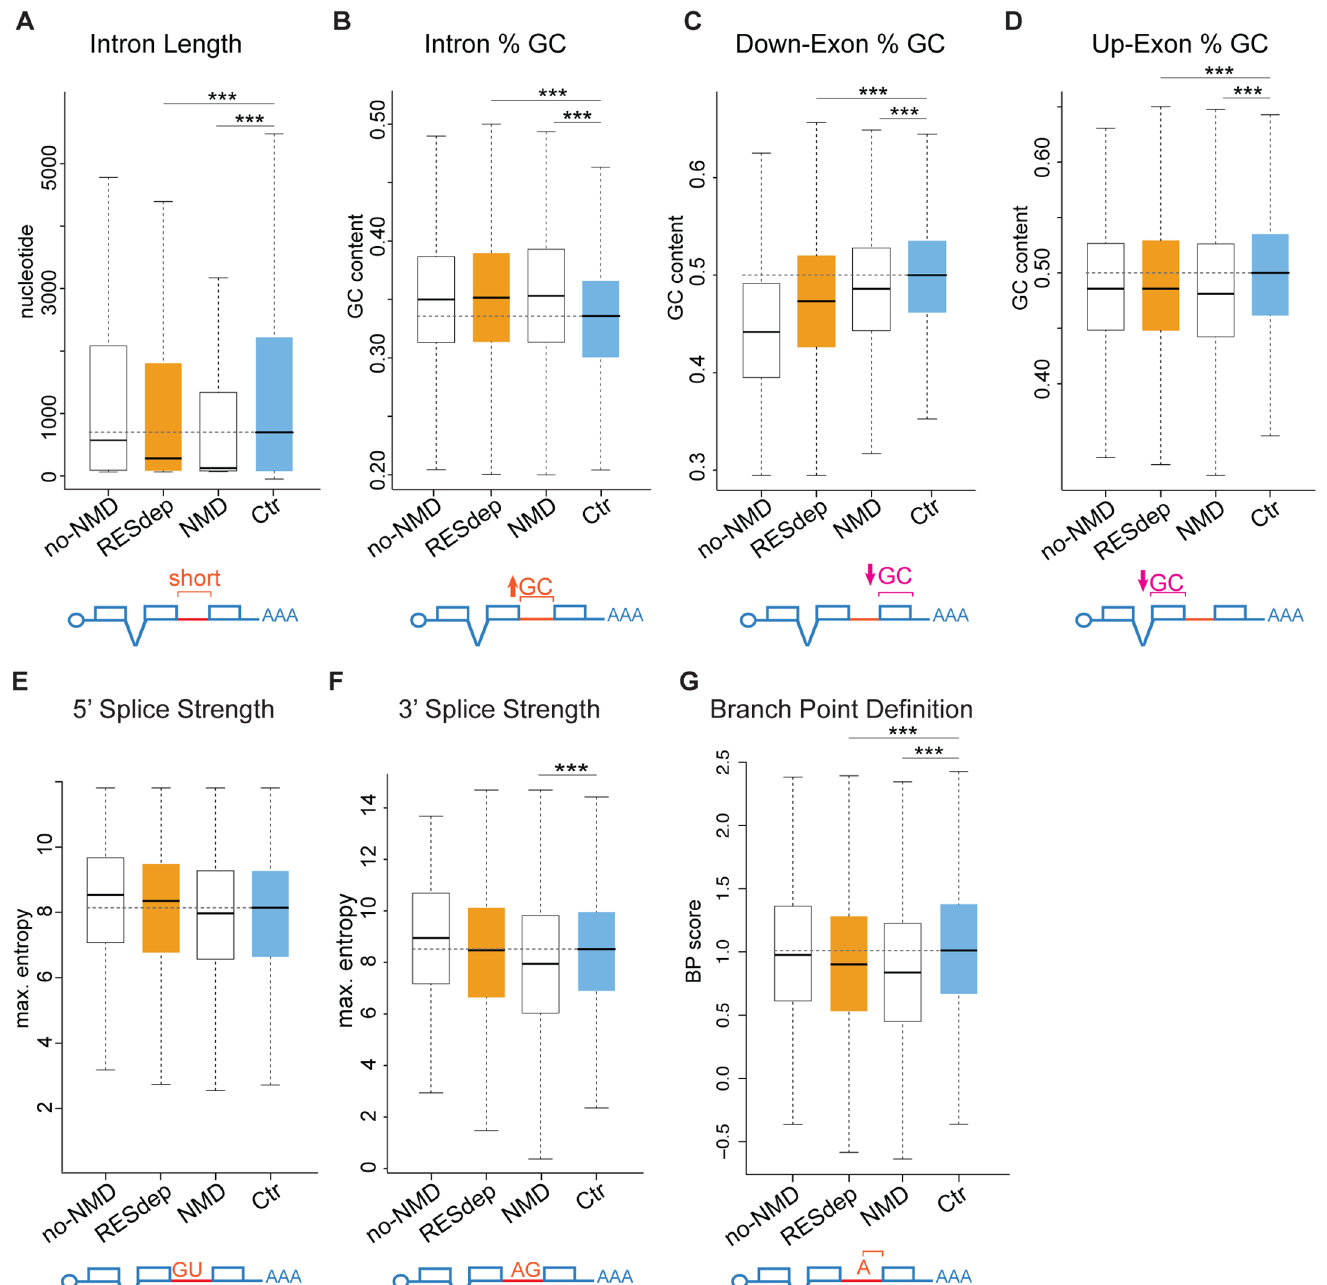
Fig 5. Molecular features that determine intron retention in RES are associated with splicing through intron definition (A-G). Box plots showing the median (black solid line) and the distribution of values for multiple intron-exon features of several groups of introns of interest. “RESdep”, all highly retained introns ( Δ PIR > 15) in at least two out the three mutants in the RES complex; “no-NMD”, subset of “RESdep” retained introns that are predicted not to trigger NMD; “NMD”, subset of “RESdep” retained introns predicted to trigger NMD; and “Ctr”, control set of introns with a Δ PIR cutoff < 0.5 in the three RES complex mutants (see Materials and Methods for details). ( (cid:3)(cid:3)(cid:3) P (cid:20) 0.001; Mann-Whitney-U test). Branch point (BP) definition: BP Score of best-predicted BP. Scored base on Corvelo et al. [24] (See Materials and Methods for